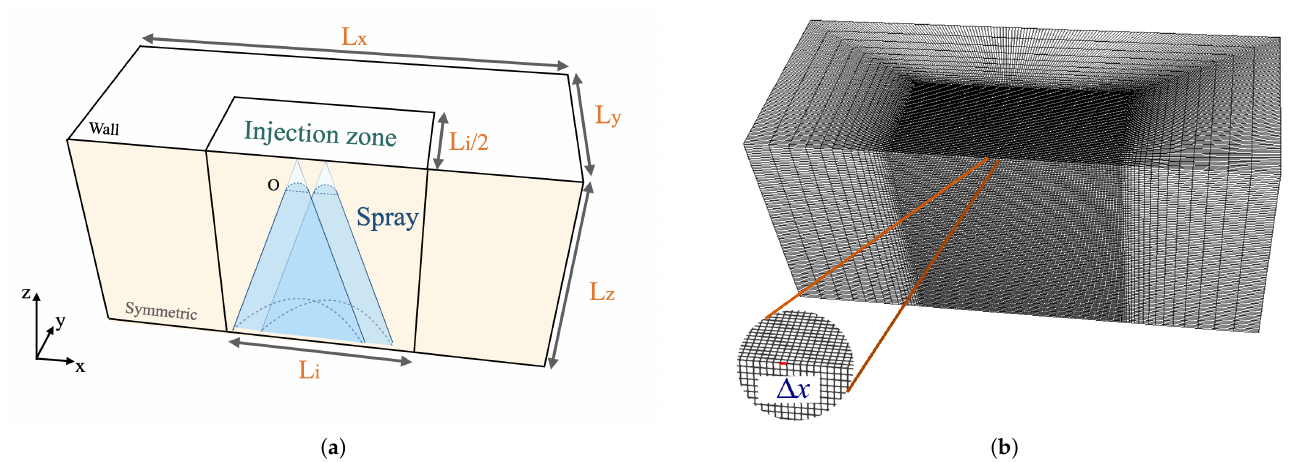
Figure 14. ( a ) Geometry and ( b ) mesh of the two spray nozzles ∆ x = 2 cm; L i = 3 m, L x = 7 m, L y = 3 m, and L z = 3.5 m with O the numerical injection plane; symmetric and wall boundary conditions highlighted in ( a